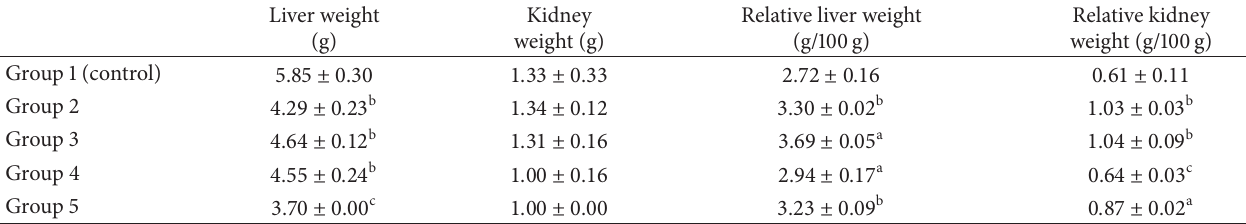
Table 4: Organ weights and relative organ weights of diabetic and non-diabetic rats.